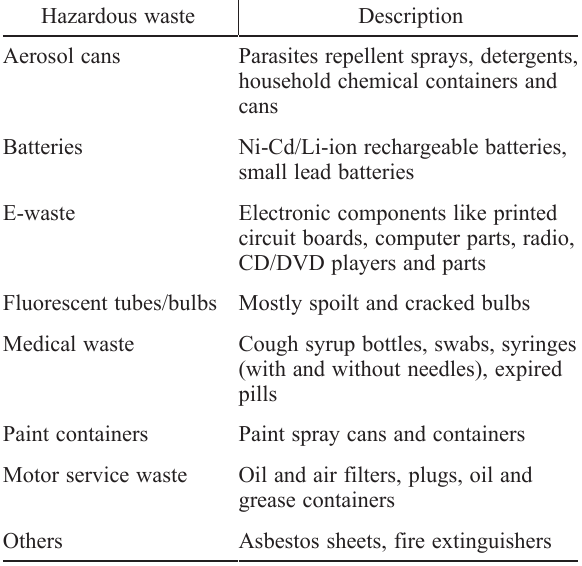
Table 2 – Components of disposed hazardous